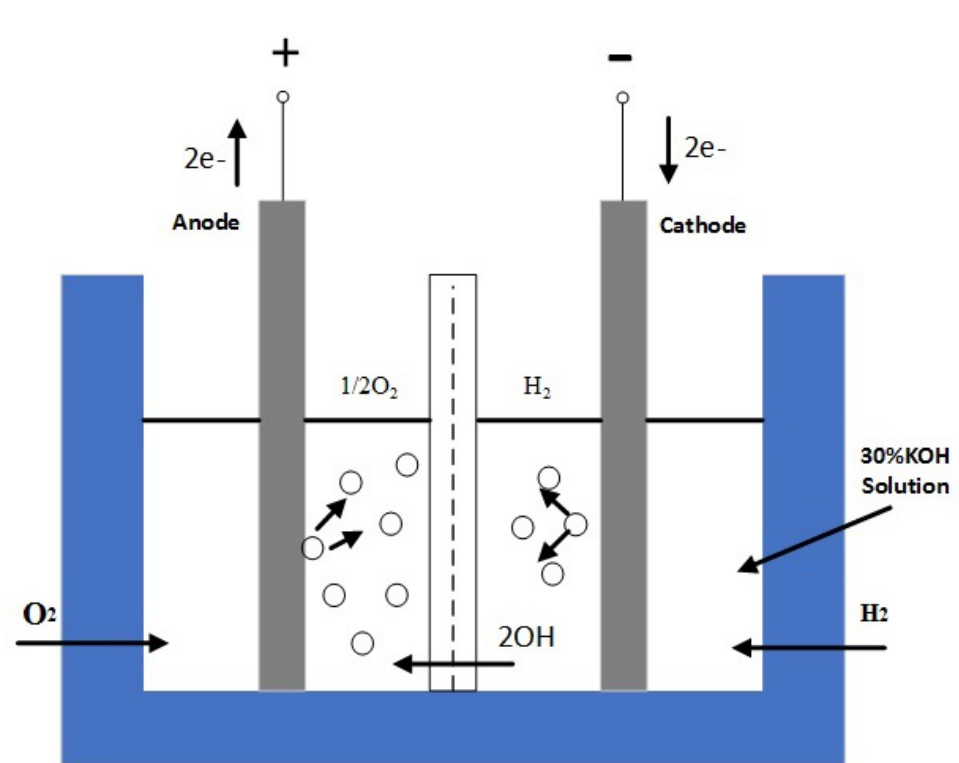
Figure 10. The principle of hydrogen production by water electrolysis of floating offshore wind power.